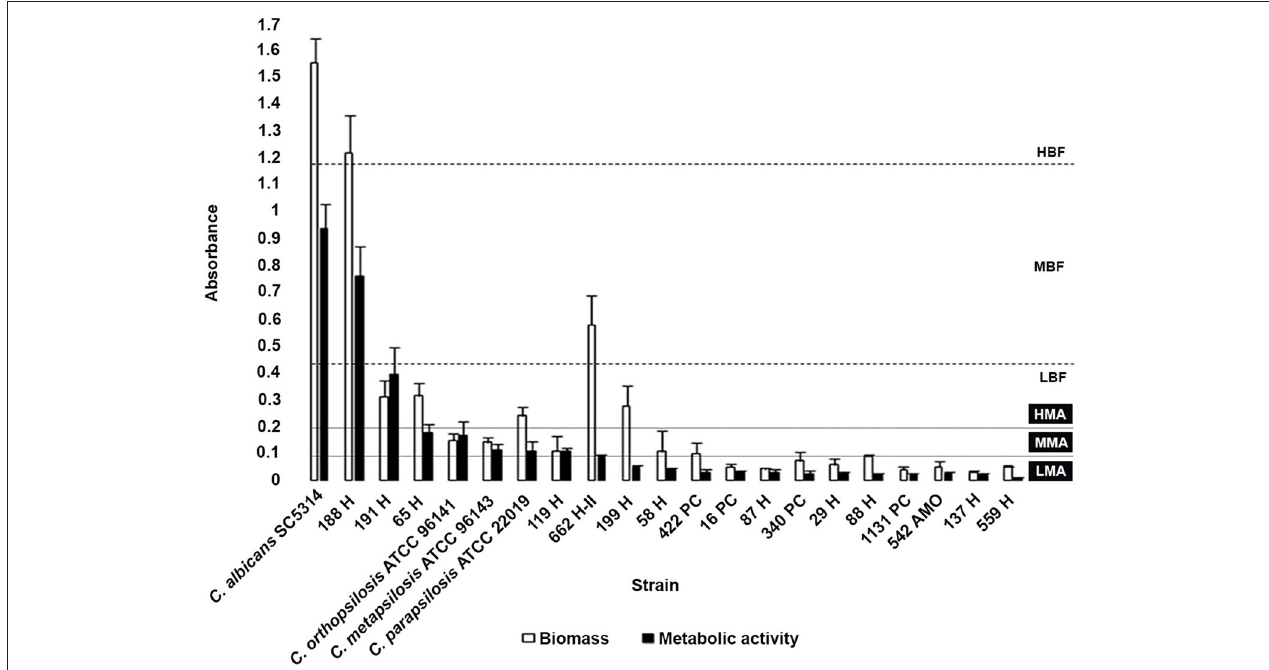
FIGURE 1 | Comparison of biomass and metabolic activity of the biofilms formed by Candida parapsilosis complex reference strains and clinical isolates. Classification according to biomass production: LBF, Low biofilm-forming; MBF, Moderate biofilm-forming; and HBF, High biofilm-forming; and according to biofilm metabolic activity: LMA, Low metabolic activity; MMA, Moderate metabolicactivity; and HMA, High metabolic activity (Marcos-Zambrano et al., 2014). Candida albicans SC5314 reference strain was employed as biofilm formation control. Each result is representative of at least three experiments. Error bars represent standard deviation.